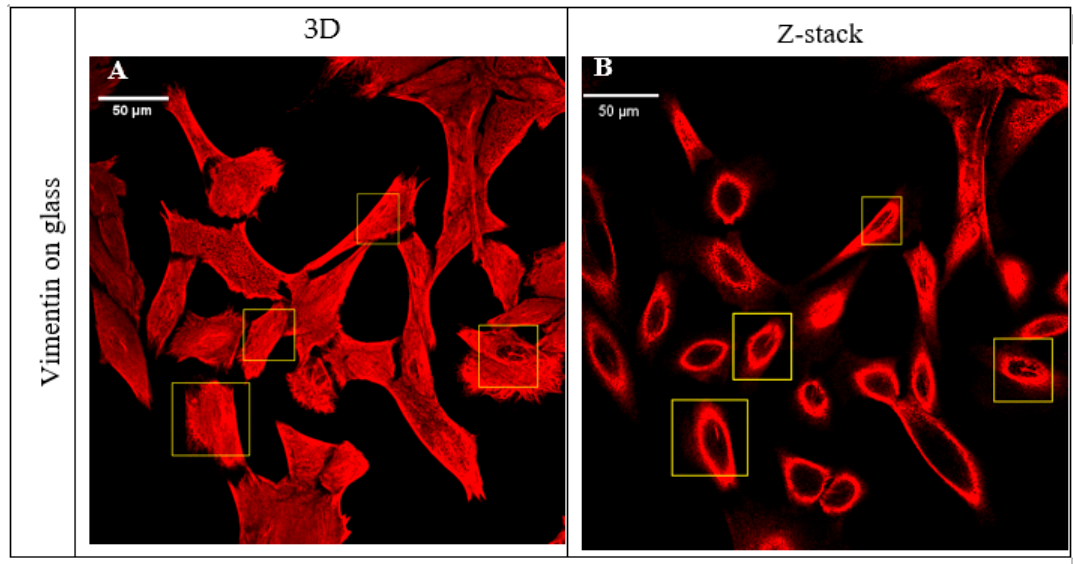
Figure 1. Vimentin in MEF 3T3 cells cultured on glass. The regions marked with the yellow frame present the cells in which there could be observed a thicker bundle of vimentin fibers above the nucleus. Pictures present overall projection ( A ) and single Z-section image ( B ).